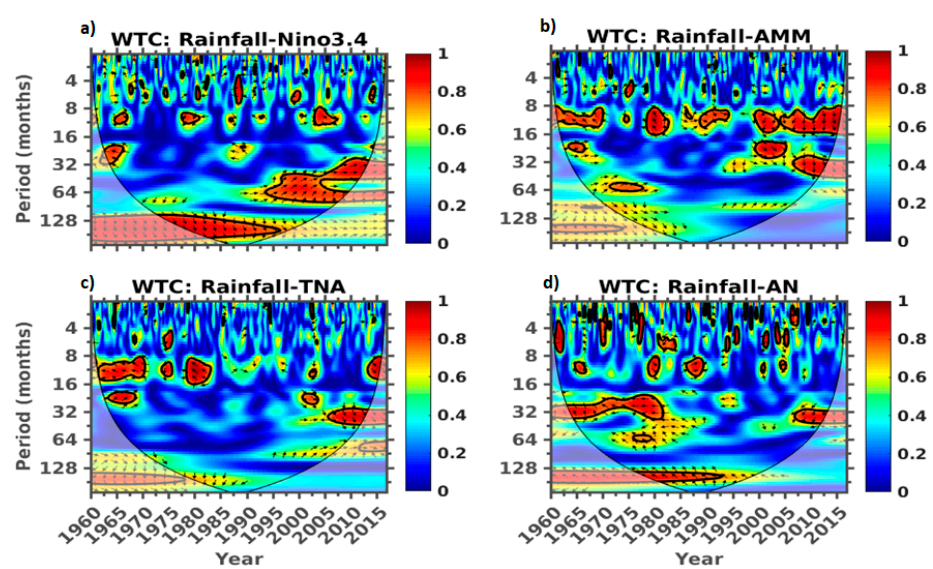
Figure 13. Coherence between rainfall and Niño3.4 ( a ), rainfall and AMM ( b ), rainfall and TNA ( c ) and rainfall and AN ( d ) 1960–2016, the phase relationship is represented by arrows. The black solid line contour delimits the region (red) where the power is strong and significant and the cone of influence (solid black line) indicates the 95% confidence level.